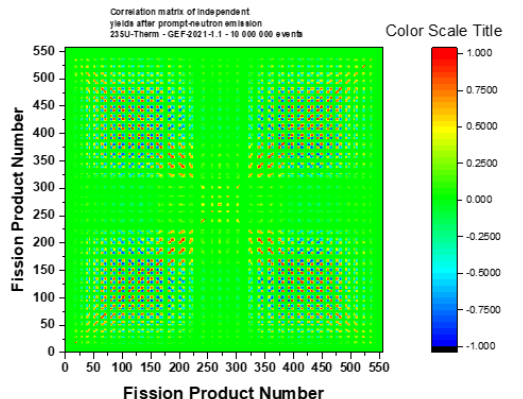
Fig. 6. Correlations of independent fission yields from the GEF-2021/1.1 code [14]